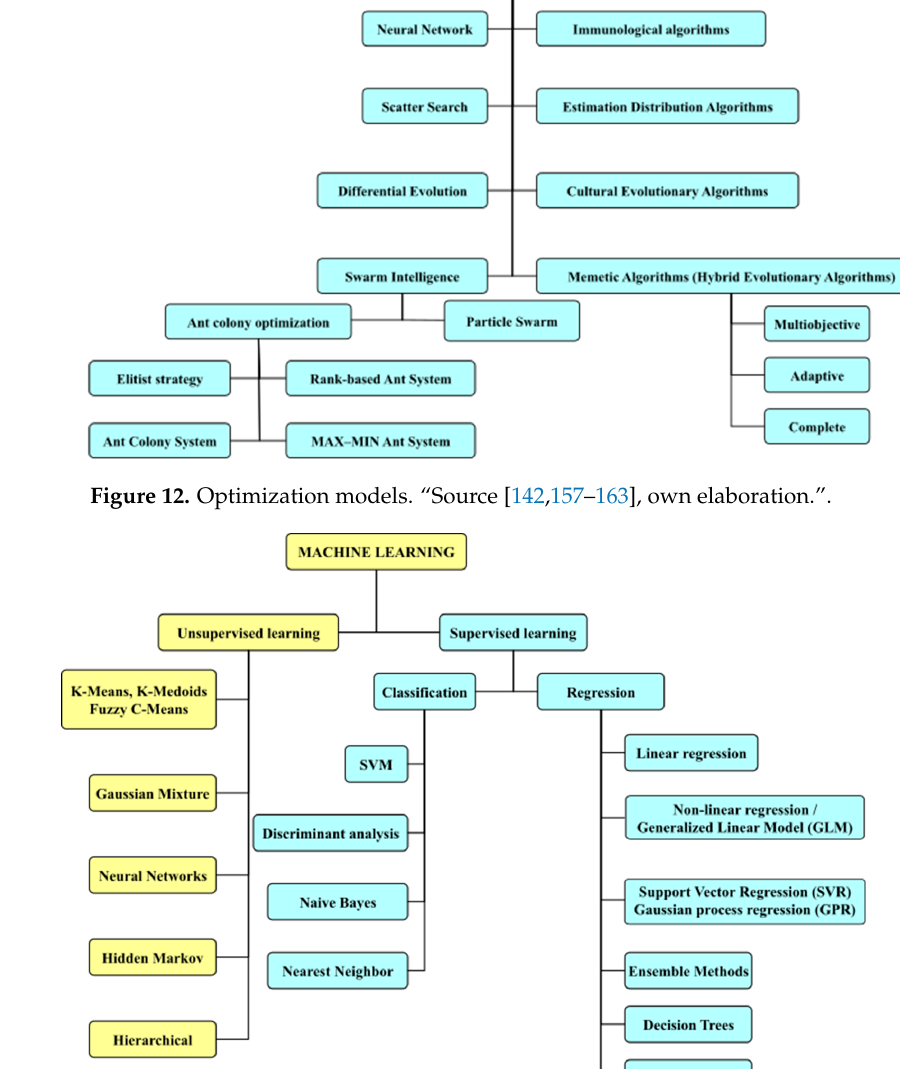
Figure 13. Classification of models used for machine learning. Taken from [169].